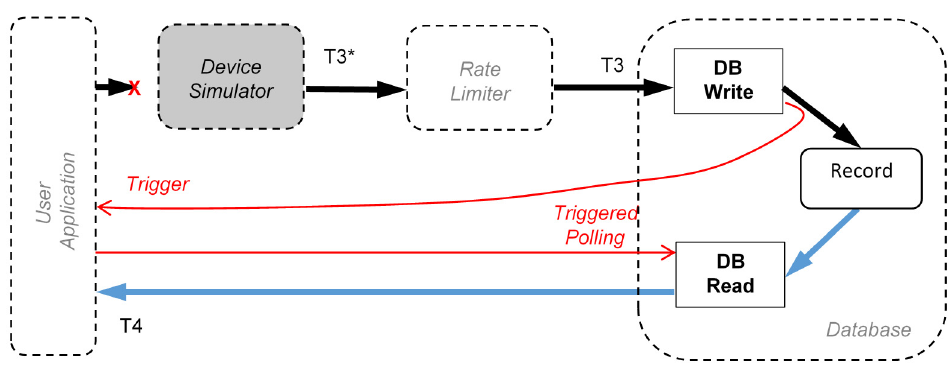
Figure 6. Adding the Device Simulator software for testing the scalability of the system under test. The Rate Limiter block is required not to violate the Database write rate